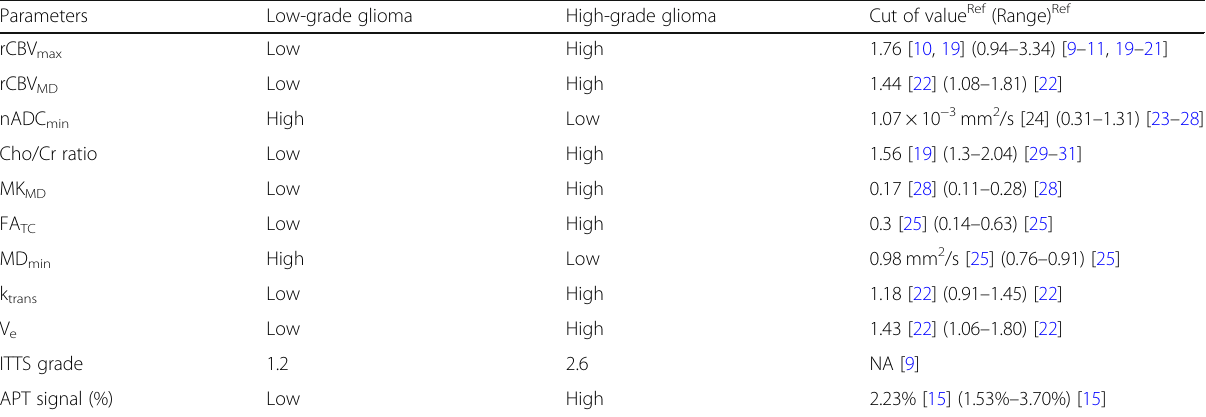
Table 1 Radiomic data for differential diagnosis of low-grade vs high-grade gliomas